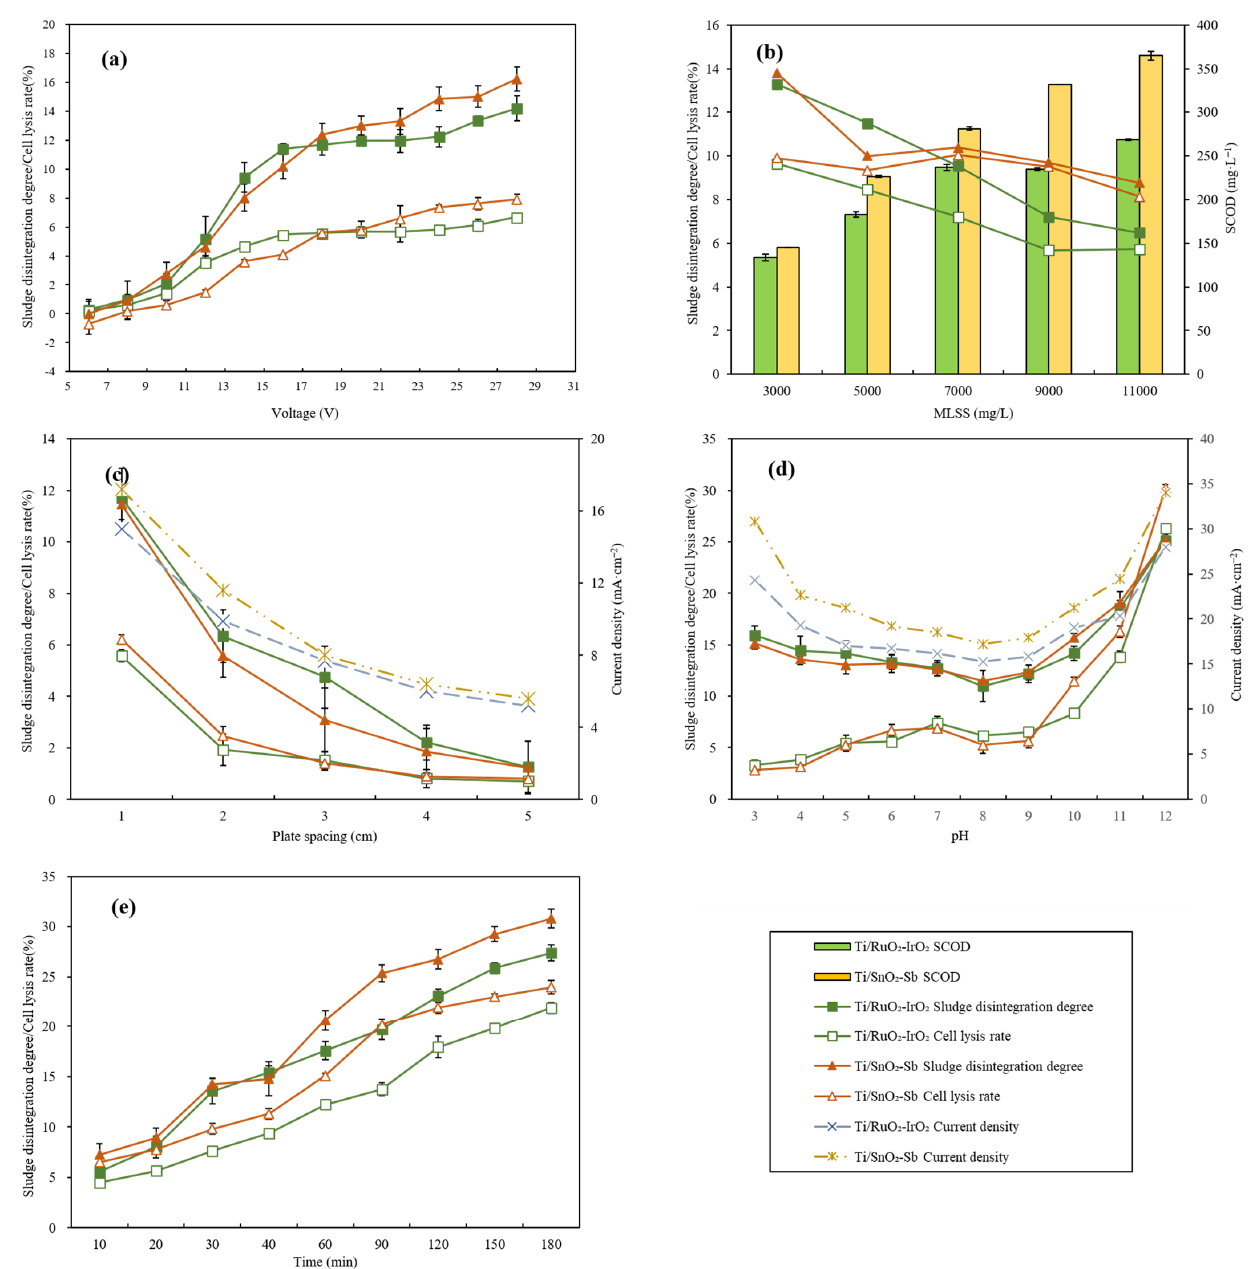
Figure 2. The effect of cell lysis using Ru-Ir and Sn-Sb electrodes varying: ( a ) Voltage, ( b ) MLSS, ( c ) Plate spacing, ( d ) pH, and ( e ) Time.